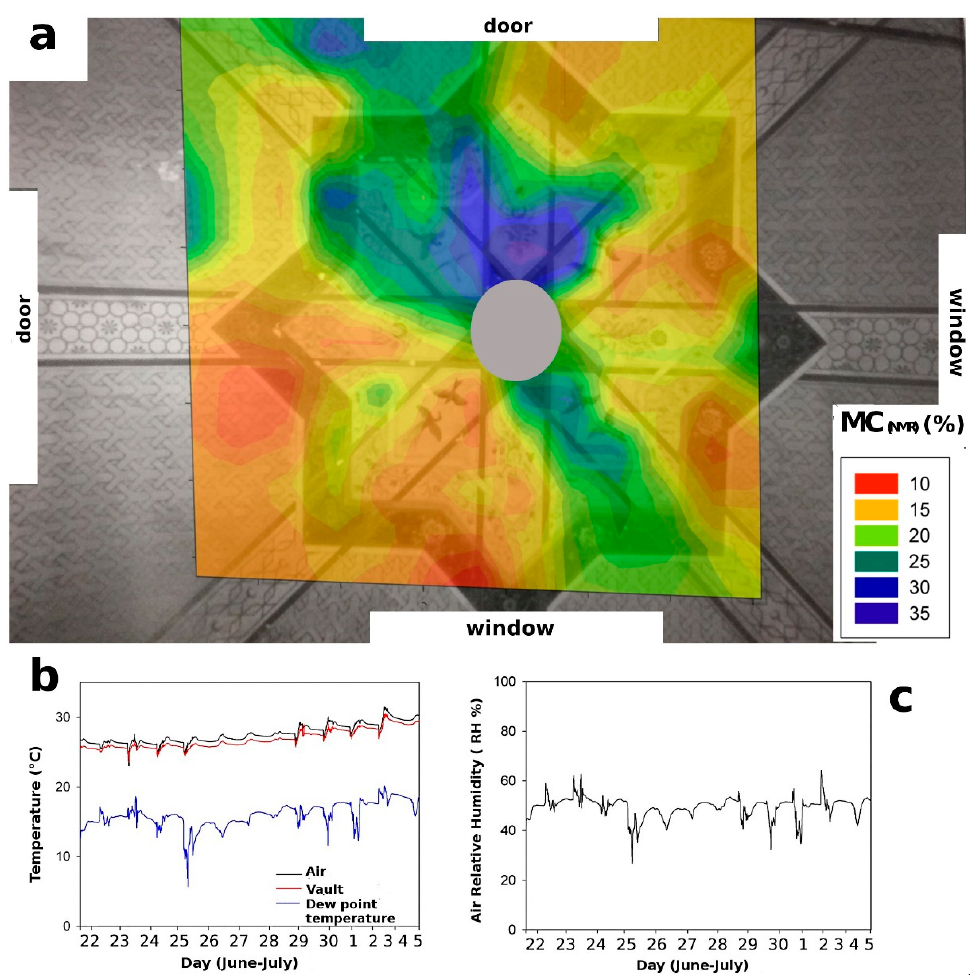
Figure 1. ( a ) NMR moisture, (MC NMR ) distribution map of painted vault measured in the Turkish room. The water content is shown as a gradient of color. Red indicates the lowest content of absorbed water, and blue indicates the highest content. The legend shows the percentage of MC (NMR) . ( b ) Temperature of the air and vault ( ◦ C), dew point temperature ( ◦ C) on the vault surface; ( c ) Relative humidity of air (RH%). The maximum error on MC (NMR) values was evaluated using the error propagation theory and it was found to be less 10% of the nominal value.